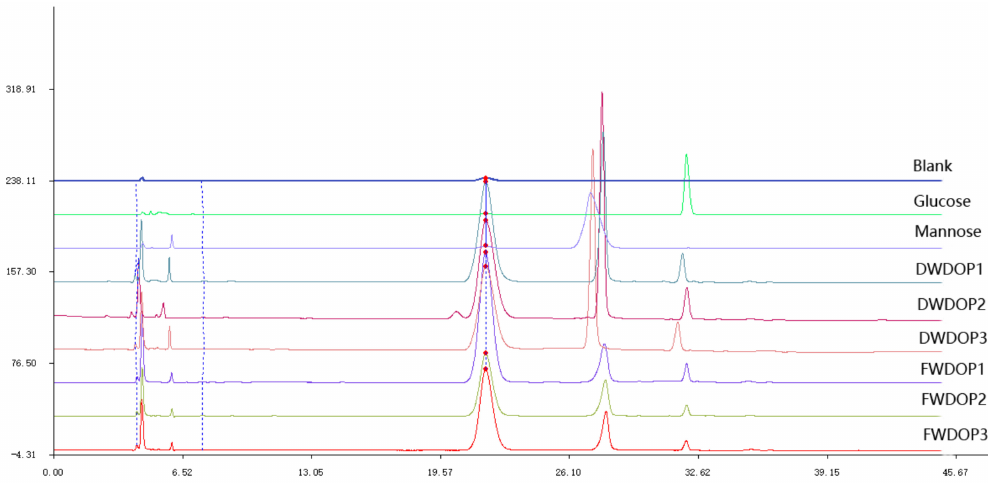
Figure 2. The HPLC of blank control solution, glucose standard solution, mannose standard solution and pure polysaccharides fractions DWDOP1, DWDOP2, DWDOP3, FWDOP1, FWDOP2,